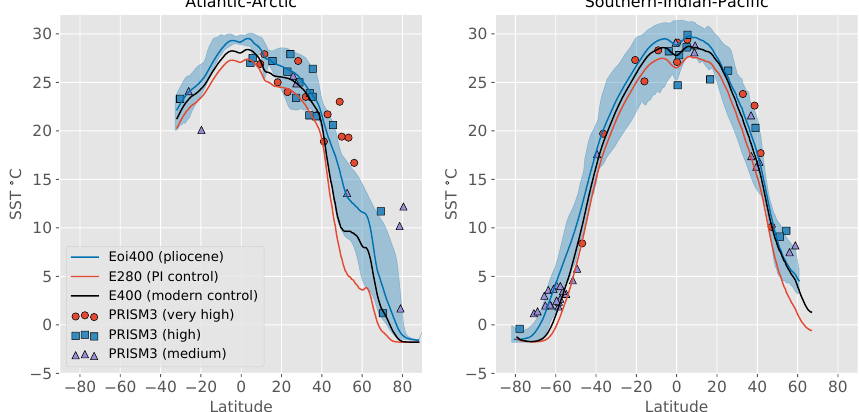
Figure 12. The zonal mean SSTs for the 400ppmv mid-Pliocene E oi 400 P (cid:104) 2691 , 2720 (cid:105) , modern control E 400 P (cid:104) 1931 , 1960 (cid:105) , and PI control E 280 P (cid:104) 5131 , 5160 (cid:105) for two oceanic basins. On the left are the zonal means over the Atlantic and Arctic basins, and the zonal mean over the Southern, Indian, and Pacific oceans is shown on the right. The data points are the PRISM3 estimates for SSTs (Dowsett et al., 2010), which have been categorized into three confidence categories (Dowsett et al., 2012). The shaded region highlights the range of the simulated mid-Pliocene temperature in each basin. The (cid:104)(cid:105) denotes the range of model years over which the climatology was